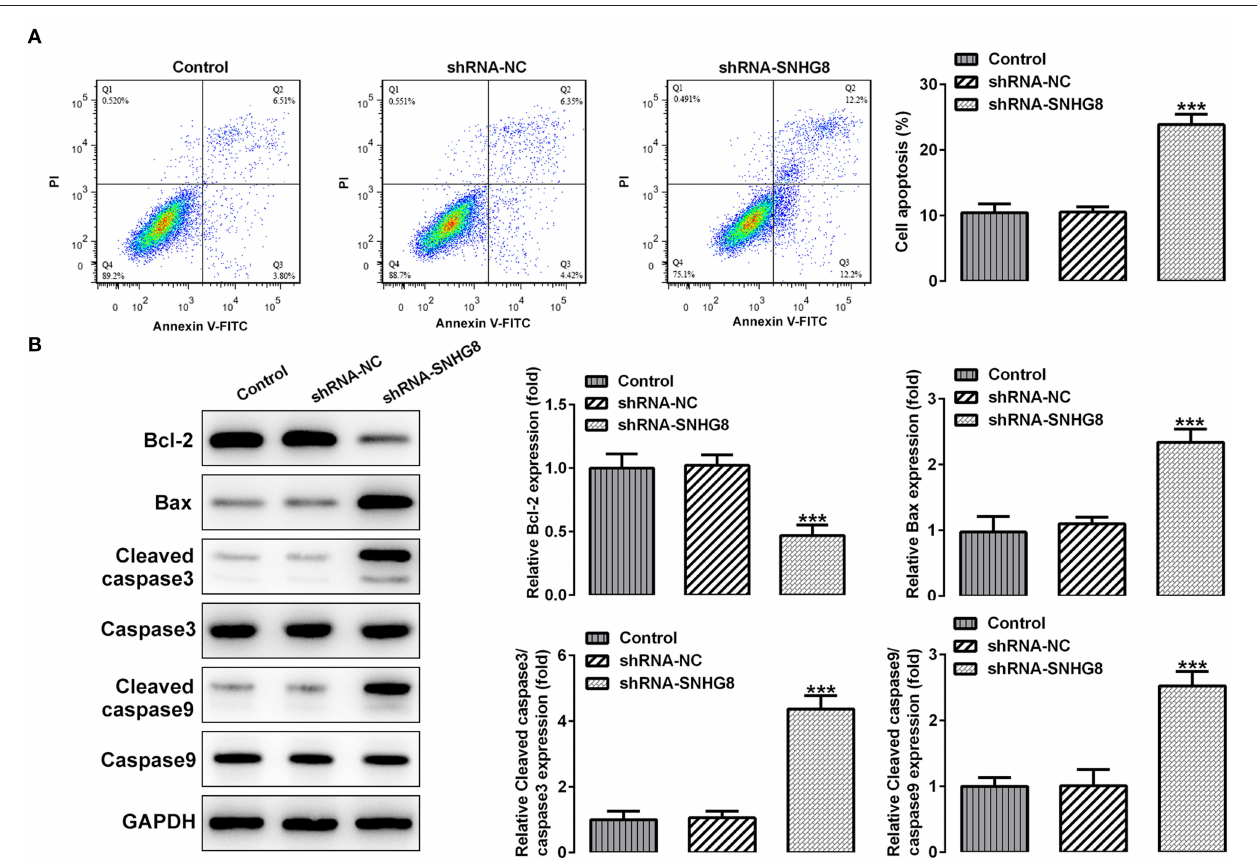
FIGURE 3 | The effect of SNHG8 silence on cell apoptosis of DLBCL. (A) The apoptotic rate of U2932 cells with or without SNHG8 silence was measured by flow cytometry. (B) The expression of proteins involved in cell apoptosis in U2932 cells with or without SNHG8 silence were measured by Western blotting. *** p < 0.001 vs.